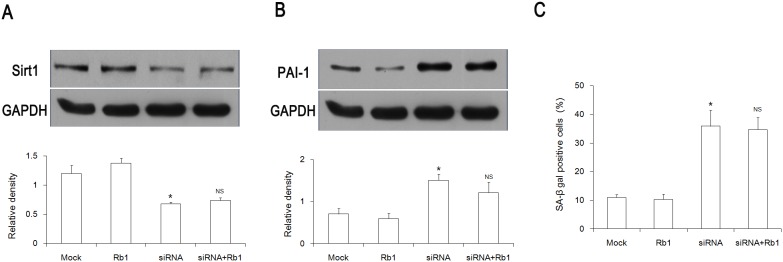
Rb1 does not inhibit Sirt1 depletion-induced senescence.(A) The Sirt1 protein level was evaluated by a Western blot analysis 72 hours after siRNA transfection with or without Rb1 supplementation. (B) The PAI-1 protein expression was examined 72 hours after siRNA transfection. (C) A total of 400 cells were counted in order to calculate the ratio of SA-β-gal–positive cells 72 hours after siRNA transfection. *P<0.01 vs Mock; NS, P>0.05 vs siRNA; n = 3. Mock, transfection reagent only group; Rb1, 20 µmol/L Rb1-treated group; siRNA, Sirt1 siRNA group; siRNA+Rb1, Sirt1 siRNA plus 20 µmol/L Rb1-treated group.